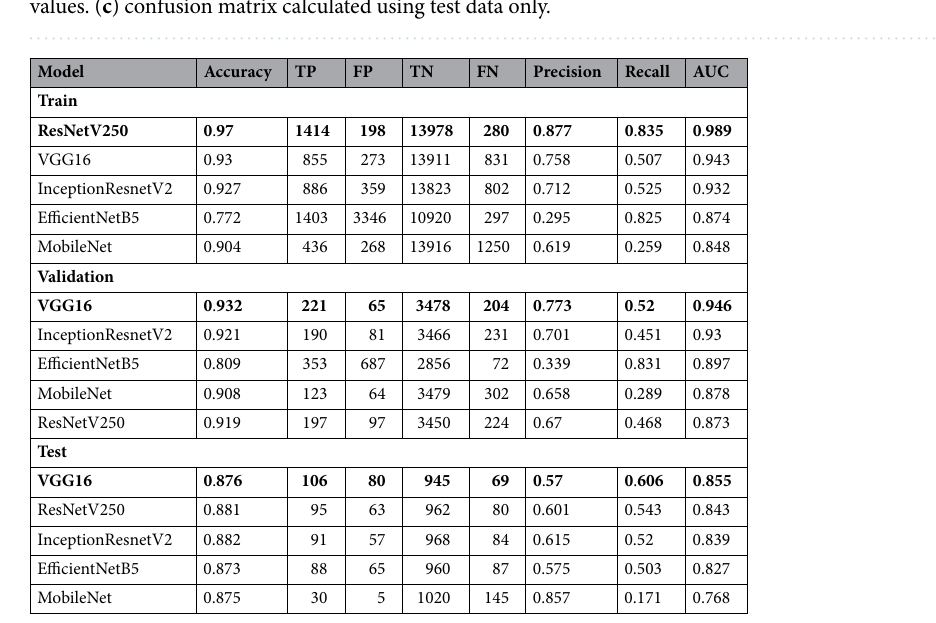
Table 2. Evaluation metrics for all tested backbone architectures. Refer to the main manuscript text for definition of evaluation metrics. The best performing models are shown in boldface. Results are sorted by